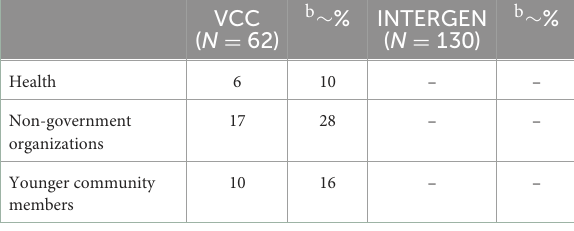
TABLE 1 Indicates broad social characteristics of VCC and survey